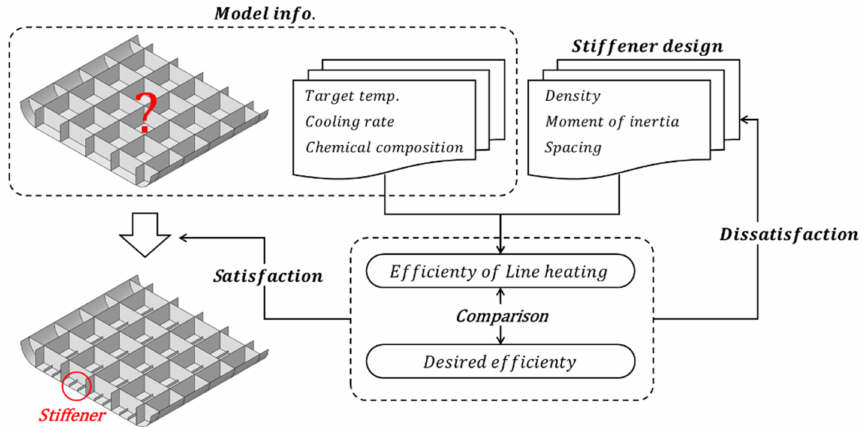
Figure 15. The procedure for determining the stiffener of the ship